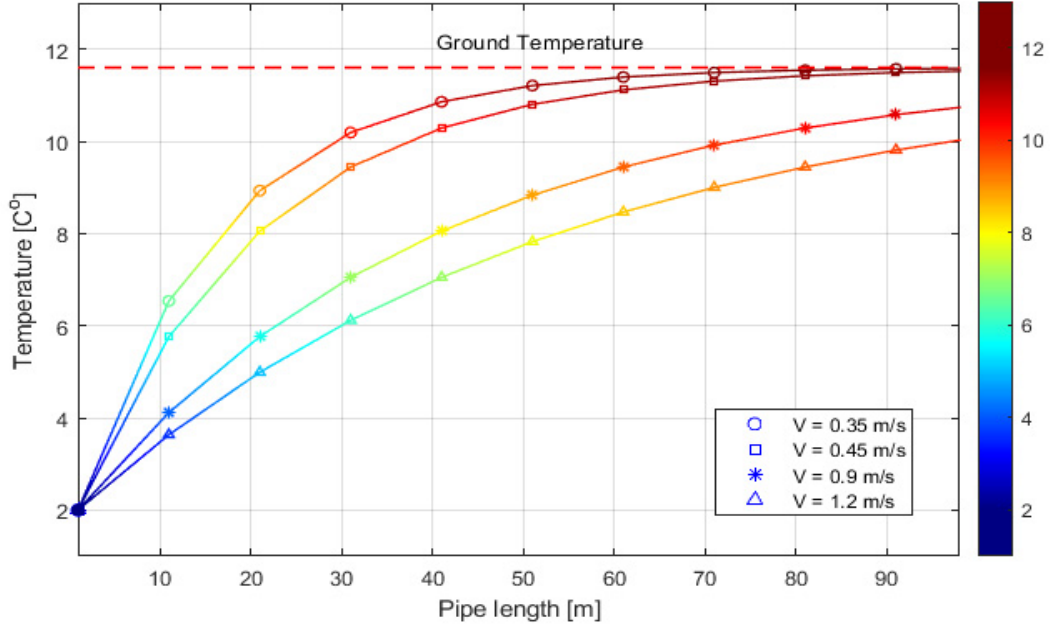
Figure 7. The water temperature behavior in a vertical single U-tube for heating mode (in the winter) at different water velocities (0.35, 0.45, 0.9, and 1.2 m/s ).